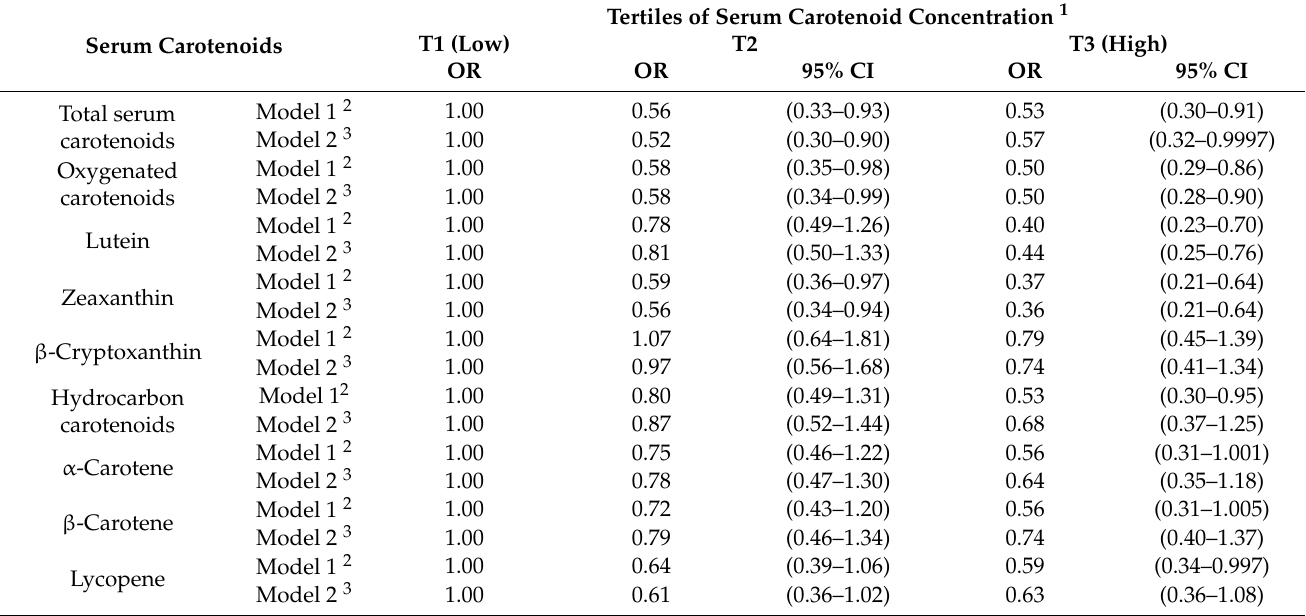
Table 2. Adjusted odds ratios and 95% confidence intervals for a high high-sensitivity C-reactive protein level according to tertiles of serum carotenoid concentration with the lowest tertile of each carotenoid as a reference using logistic regression analysis.